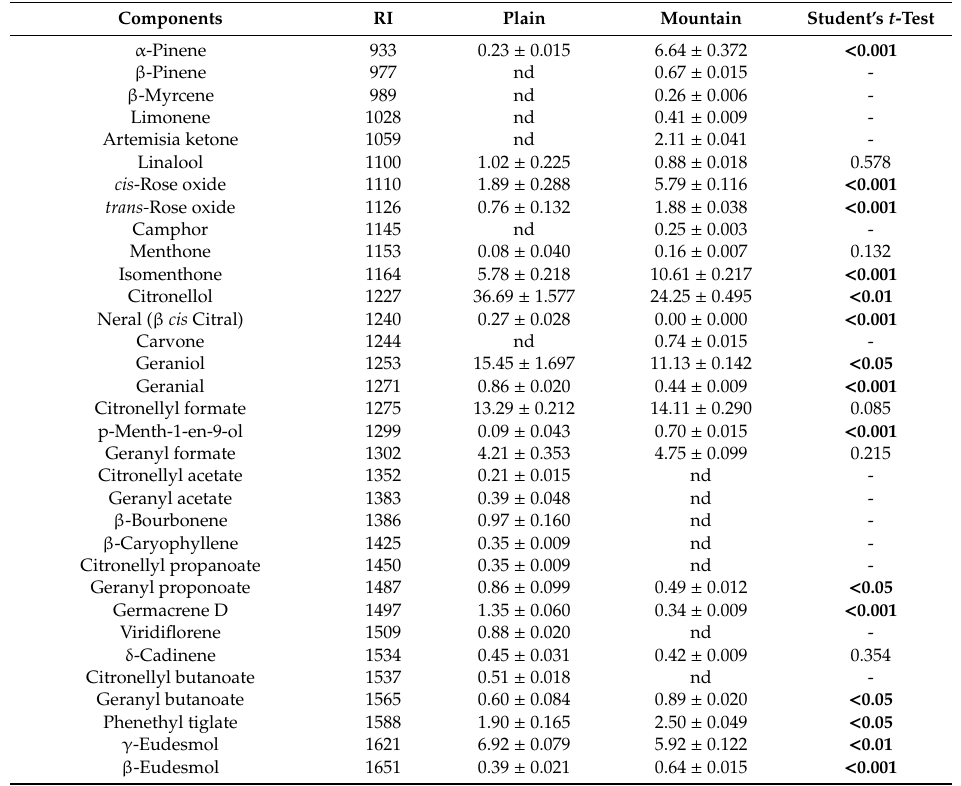
Table 7. Chemical composition (%) of essential oils of pelargonium plants grown at di ff erent altitudes (plain vs. mountain). Data are expressed as means ± SE (n = 3), and significant di ff erences ( p < 0.05, p < 0.01, p < 0.001) in bold between treatments are indicated by Student’s t -test p